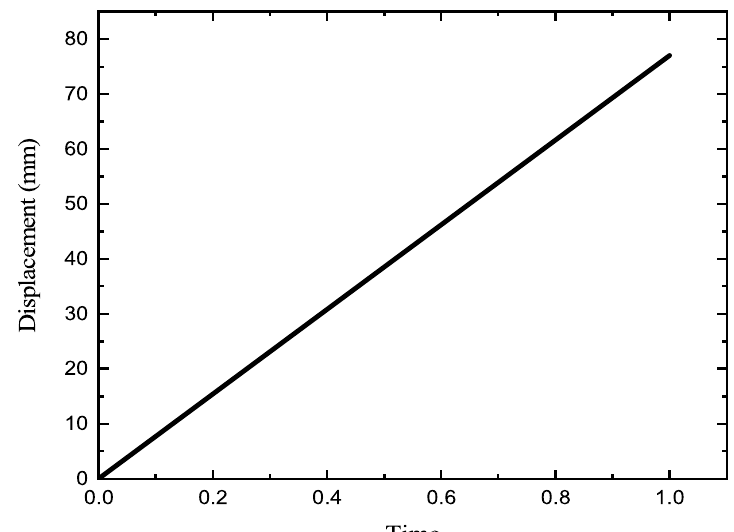
Fig. 6 Monotonic loading protocol used in the